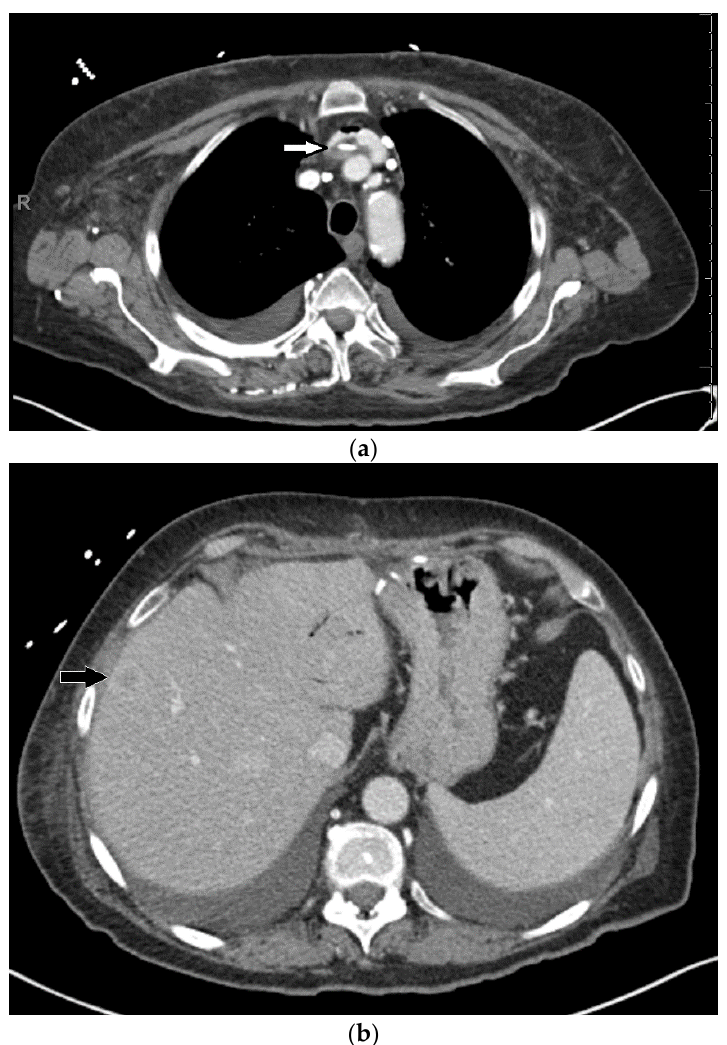
Figure 6. IV contrast-enhanced CT scan of the neck, chest, abdomen, and pelvis shows ( a ) a left-sided catheter with surrounding hypodense thrombus in the left brachiocephalic vein (white arrow), and small thrombus in the lower superior vena cava (SVC) at the SVC / atrial junction (not shown). Trace amount of iatrogenic air is also present immediately anterior to the clot in the brachiocephalic vein. ( b ) New hypo-enhancing liver lesions are also present (the black arrow denotes one of